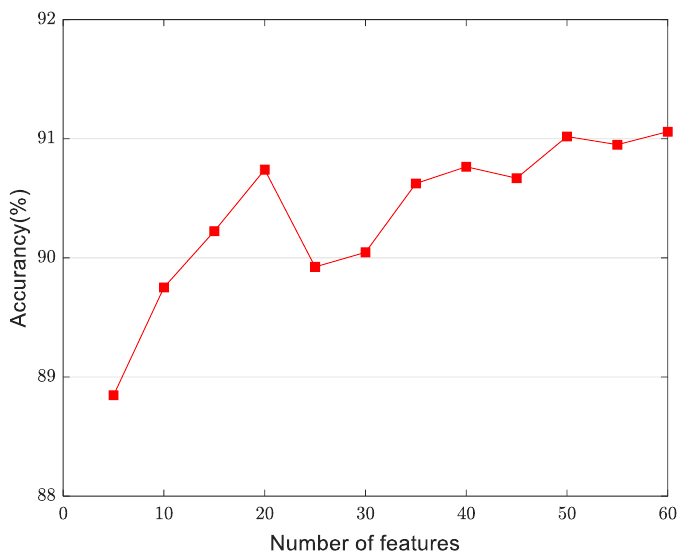
Figure 12. Identification accuracy with number of features selected by Relief-F.